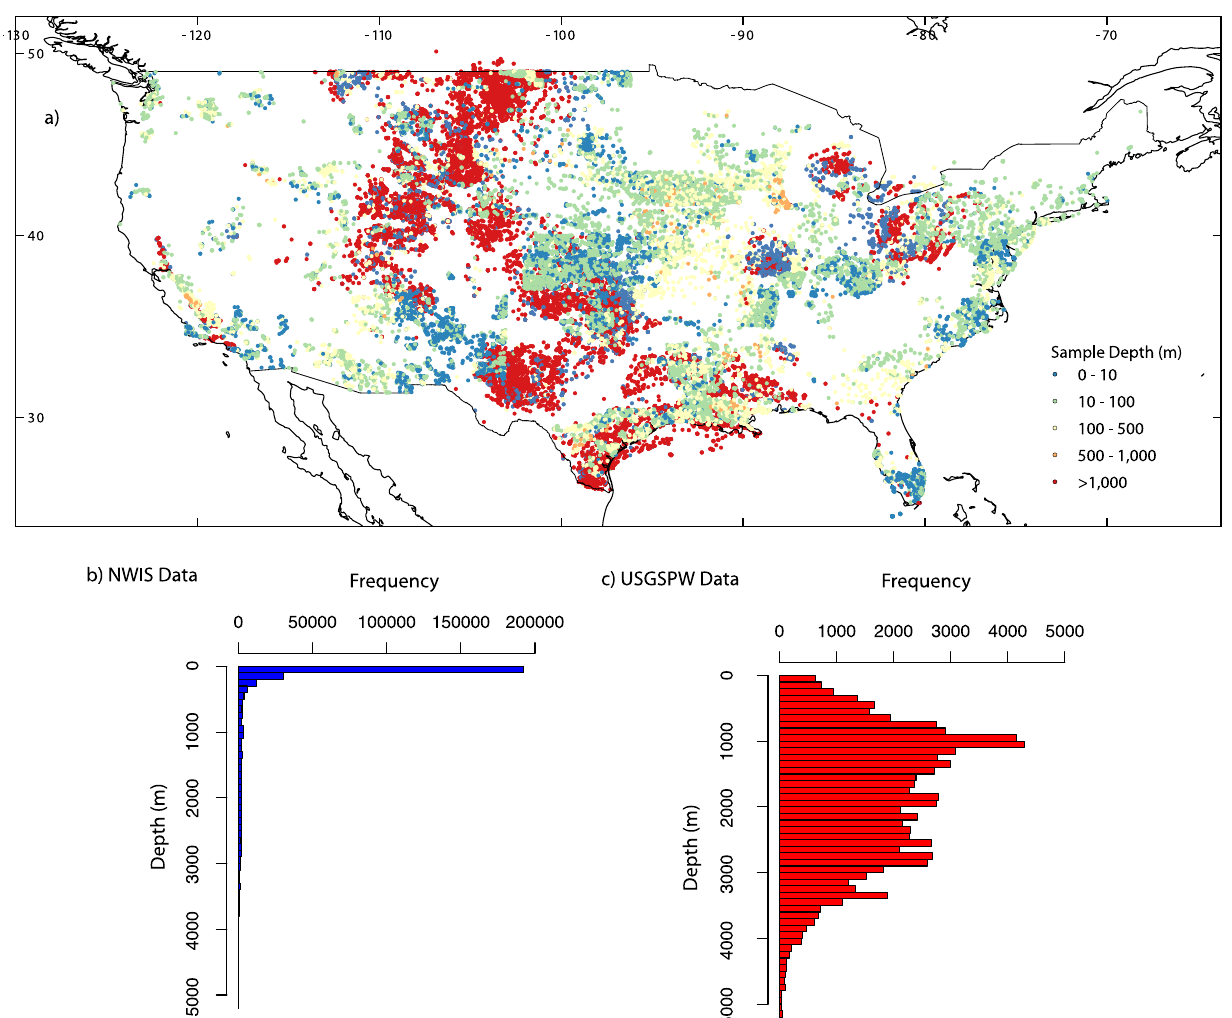
Fig. 3 Cl data from a range of geographic settings to depths >5,000 m were considered in this study. Groundwater analyses were from a various regions in the United States and various depths from b NWIS data from groundwater wells 62 and c from produced waters from the oil and gas industry 61 .